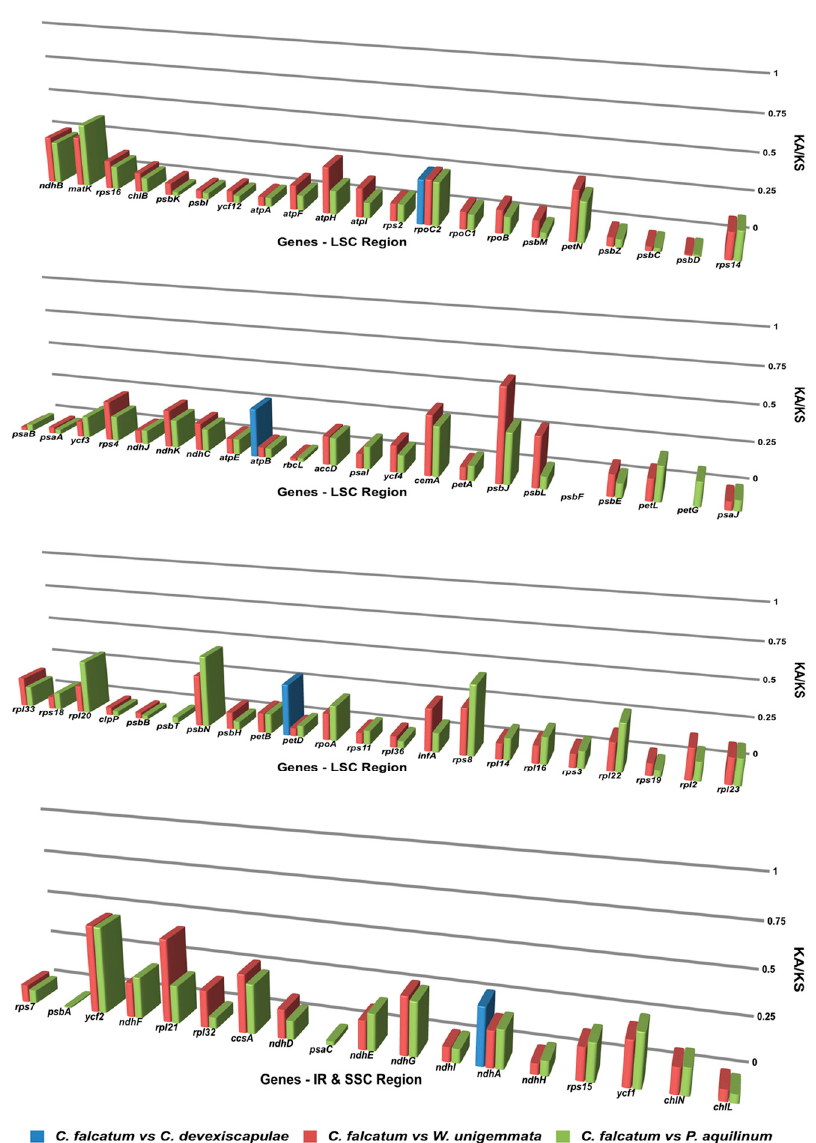
Figure 4. Synonymous/non ‐ synonymous (K A /K S ) substitution rate values for the 76 protein ‐ coding genes of C. falcatum , C. devexiscapulae , W. unigemmata and P. aquilinum . The blue boxes indicate the K A /K S ratio of C. falcatum compared to C. devexiscapulae , the red boxes indicate the K A /K S ratio of C. falcatum compared to W. unigemmata and the green boxes indicate the K A /K S ratio of C. falcatum compared to P. aquilinum .